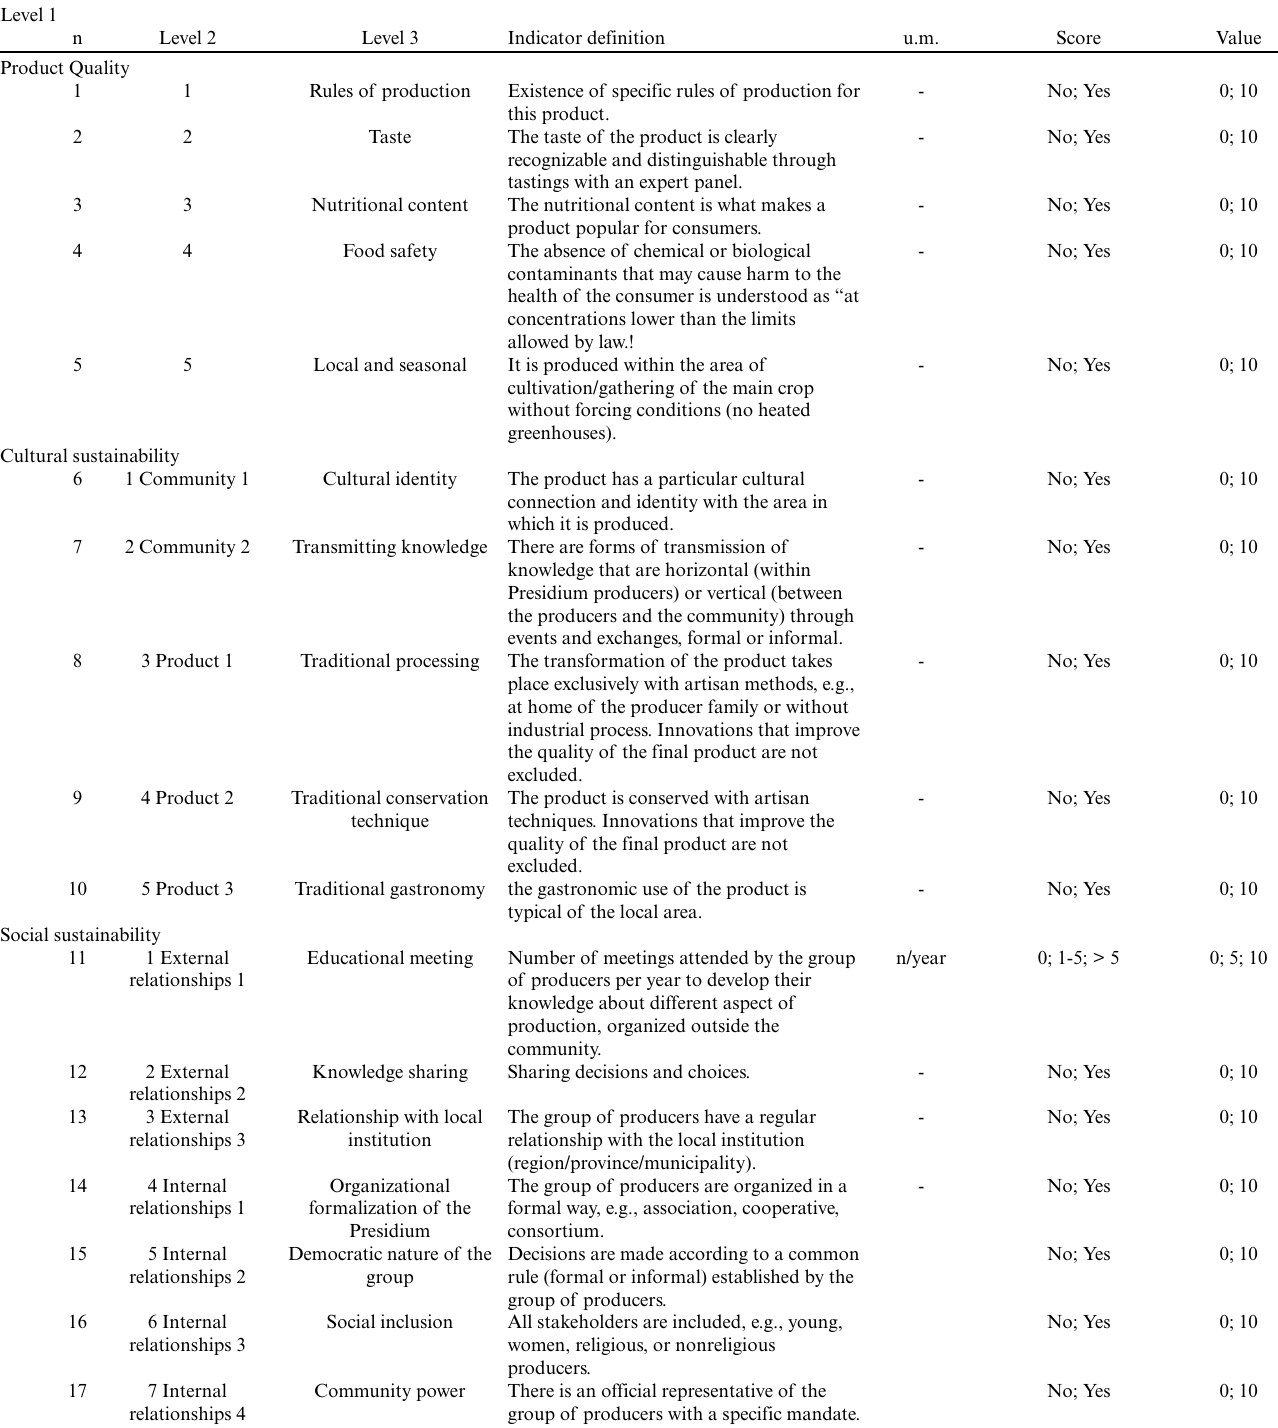
Table 2 . List of indicators used to evaluate quality and environmental, social, economic, and cultural aspect of sustainability of Slow Food Presidia, with their dimension (level 1, 2, and 3), definition, unit of measurement (u.m.), scores, and value. Level 1 n Level 2 Level 3 Indicator definition Product Quality